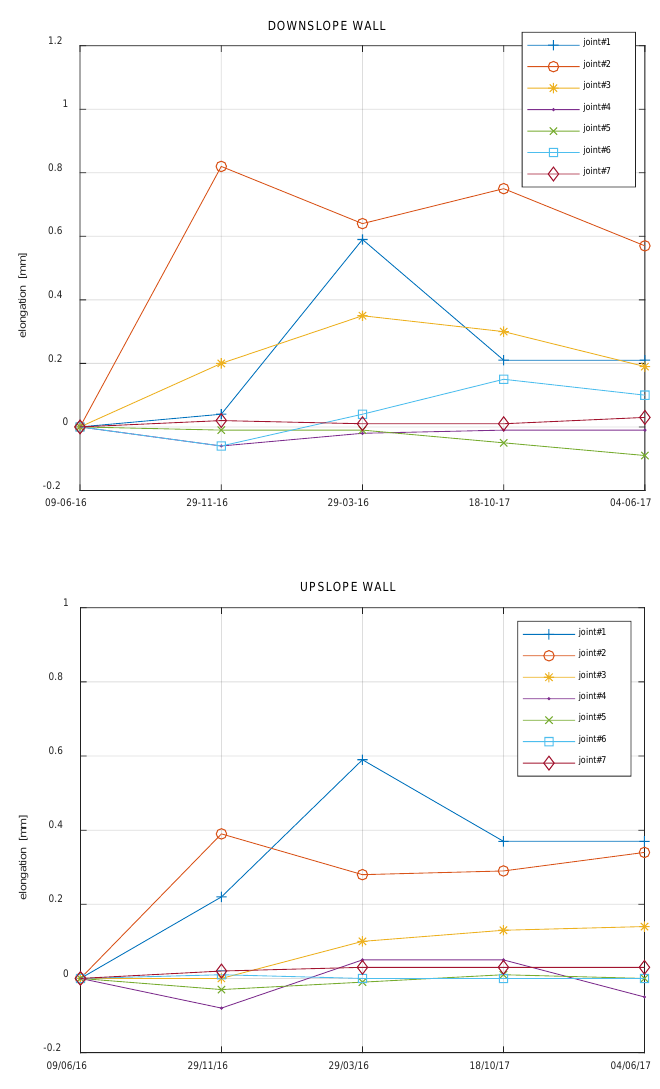
Figure 7. Elongation against time of the optical fiber corresponding to the tunnel joints.